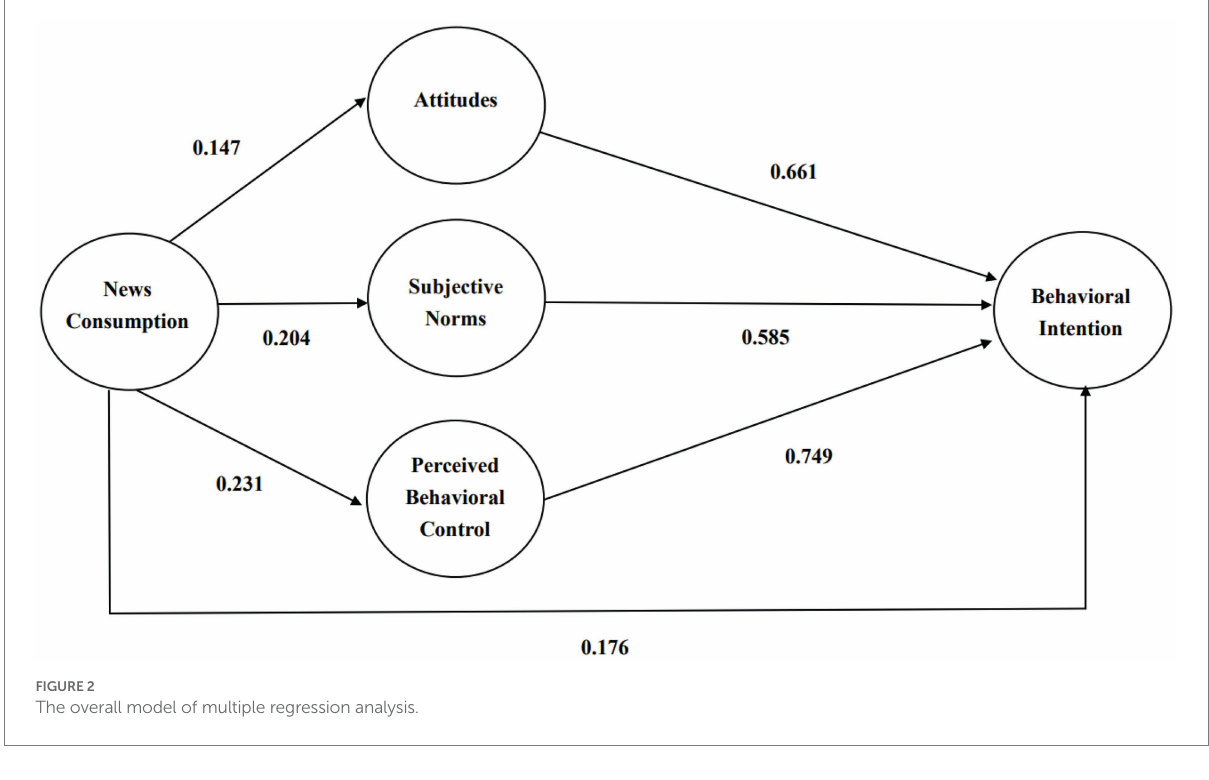
FIGURE 2 The overall model of multiple regression analysis.